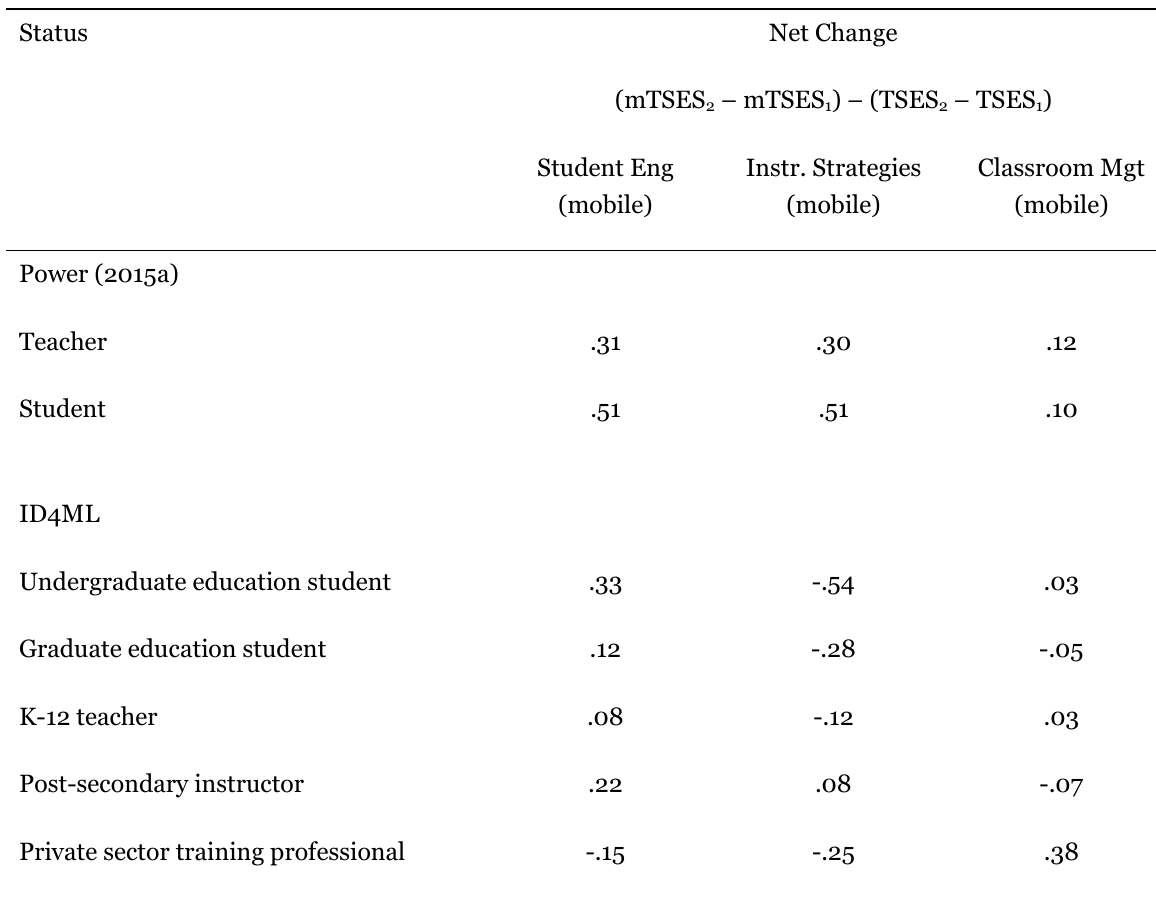
Net Change (Intervention Effect) According to Participant